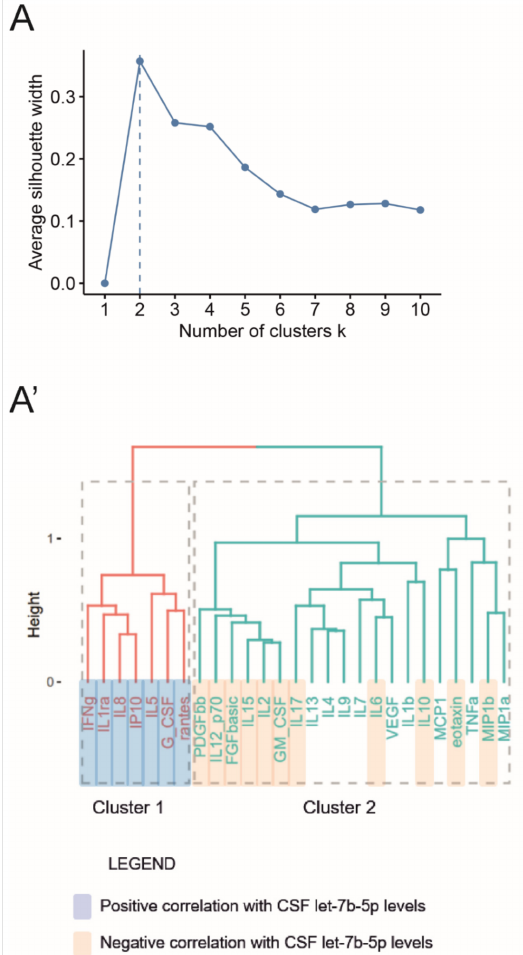
Figure 3. Let-7b-5p is an anti-inflammatory regulator of the complex pathway of soluble biochemical factors circulating in the MS CFS. By means of hierarchical cluster analysis, we divided in homogeneous groups, the 27 inflammation-related proteins (variables), quantified by multiple assays on 166 MS patients at T0. ( A ) We used the silhouette method to identify the optimal number of clusters, equal to two main clusters ( A’ ) The result of this analysis was represented as a dendrogram: cluster 1 (red) with 7/27 inflammatory proteins (IFN γ , IL1ra, IL8, IP10, IL5, G_CSF, RANTES); cluster 2 (blue) including 20/27 inflammatory proteins (PDGFbb, IL12_p70, FGFbasic, IL15, IL2, GM_CSF, IL17, IL13, IL4, IL9, IL7, IL6, VEGF, IL1 β , IL10, MCP1, eotaxin, TNF α , MIP1a,